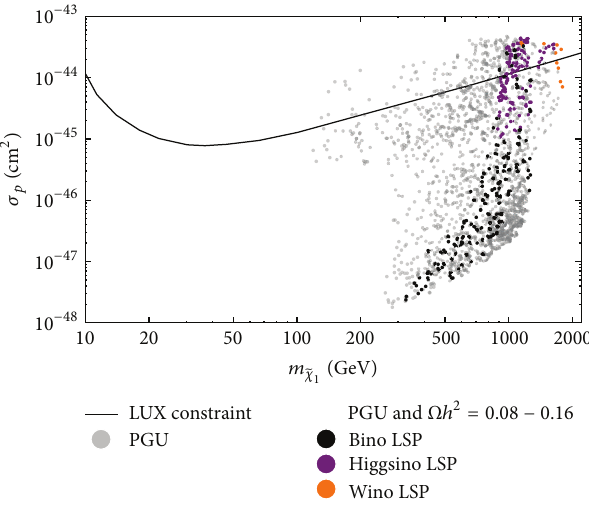
Figure6:Neutralino-protoncrosssectionforthebenchmarkpoints with successful gauge coupling unification. The colour coding is the same as in Figure 5. Models denoted by grey dots do not give the correct relic abundance for dark matter. Black, purple, and orange dots correspond to WIMP candidates that are predominantly bino, higgsino,orwino.ThecurrentlimitfromtheLUXdirectdarkmatter search [3] is also shown. The latter is valid if the lightest neutralino accounts for all dark matter in the